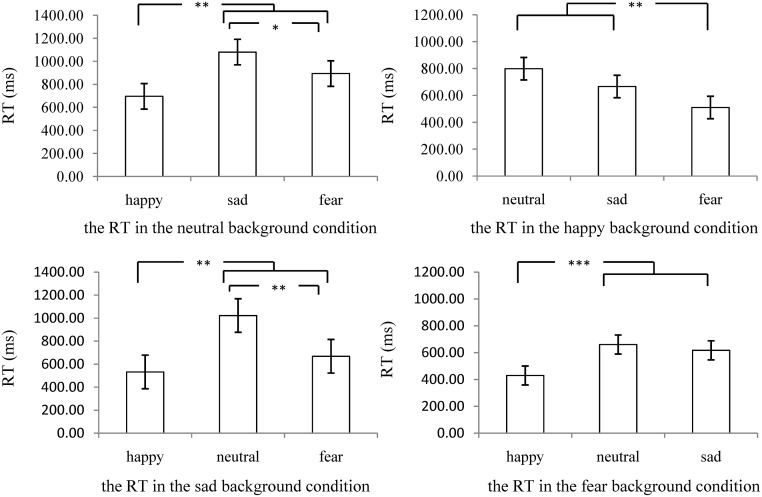
The RT of recognizing different MEs in different background conditions.“*”stands for “p< 0.05”, “**”stands for “p< 0.01”, “***”stands for “p< 0.001”. Error bar represents standard errors.